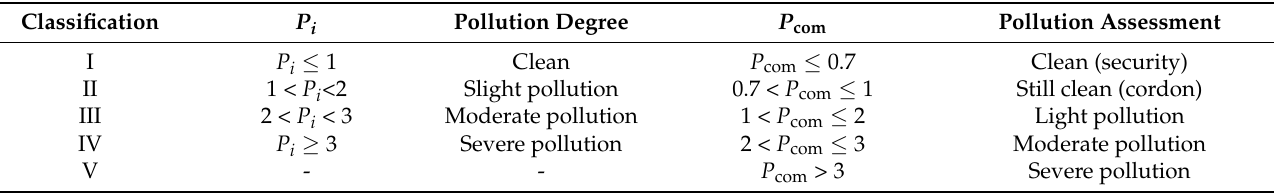
Table 2. Classification of the SPI and